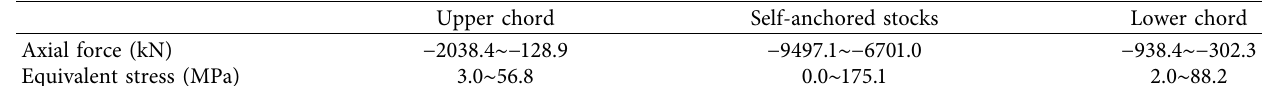
Table 7: Statistical table of equivalent stress of main load-bearing structure.